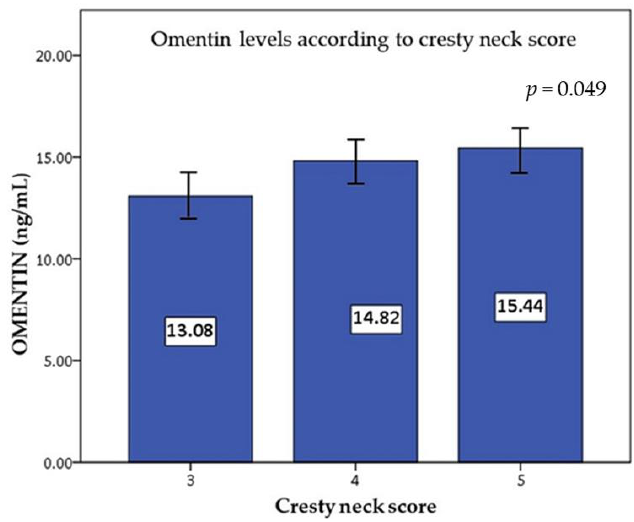
Figure 1. Omentin levels according to cresty neck score.